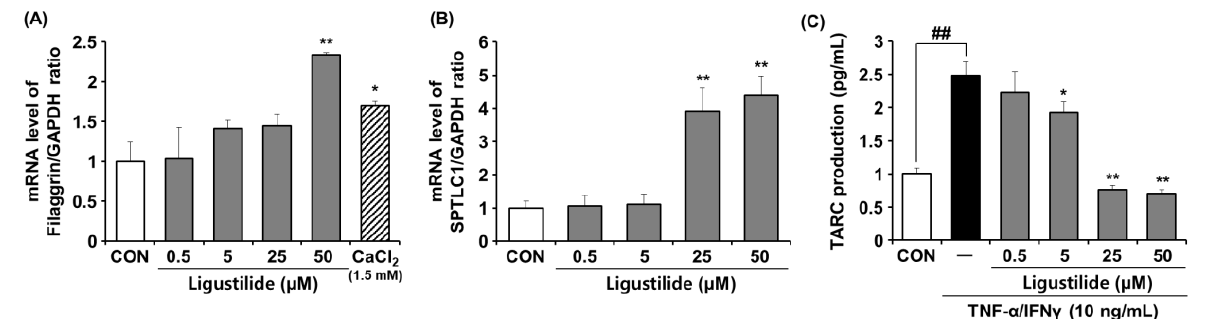
Figure 5. Effects of ligustilide on the mRNA expression of filaggrin and SPTLC1 and production of TARC in HaCaT cells. ( A ) Filaggrin and ( B ) SPTLC1 were determined by RT-PCR. ( C ) TARC pro- duction was measured by using ELISA. Data represent the mean ± SD of three independent experi- ments. Statistical significance was assessed by one- way ANOVA followed by Tukey’s test. * p < 0.05, ** p < 0.01, and ## p < 0.01 compared with the untreated cells and control, respectively. SPTLC1; Serine-palmitoyltransferase, TARC; T hymus and activation-regulated chemokine, TNF- α; Tumor necrosis factor α, IFN - γ; Interferon γ.